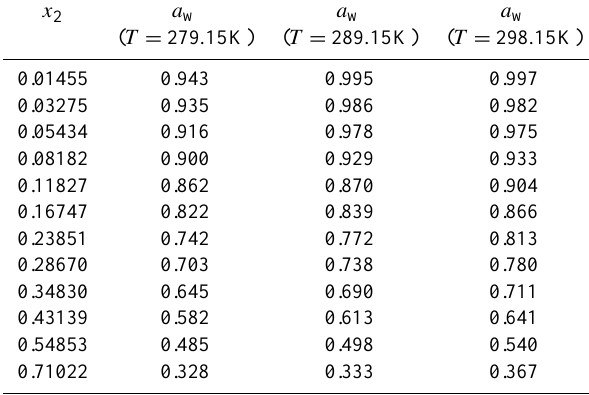
Table 6. Bulk water activity (a w ) measurements ∗ of water (1) + 2-(2-ethoxyethoxy)ethanol (2) solutions at three different tempera- tures. Solution compositions are given in mole fraction ( x 2 ) of the organic component (2).